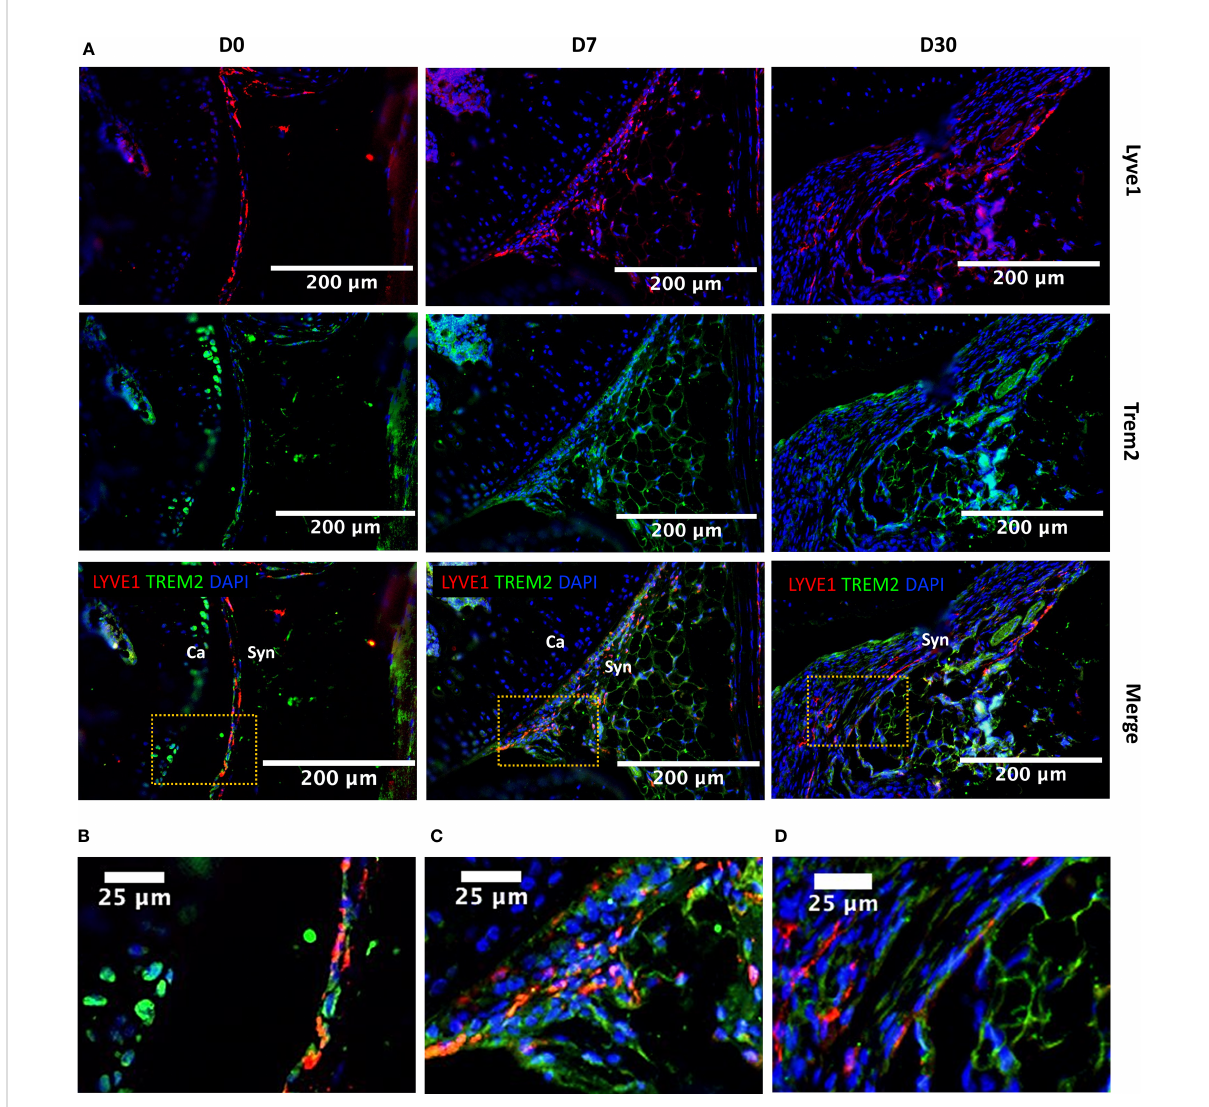
FIGURE 5 Injury-induced changes in the localization of Lyve1 hi Folr2 hi macrophages based on Lyve1 expression. (A) IHC showing Lyve1 and Trem2 expression in macrophages at D0, D7 and D30 (20× magni fi cation; scale bar = 200 m m), and a closer view of the images for (B) D0, (C) D7 and (D) D30 matching to the highlighted boxes in A (scale bar = 25 m m). The Lyve1 + macrophages were primarily observed at the synovial lining at D0. The lining of Lyve1 + macrophages was disrupted after injury and these cells started to in fi ltrate the synovial membrane. Ca, cartilage; Syn,